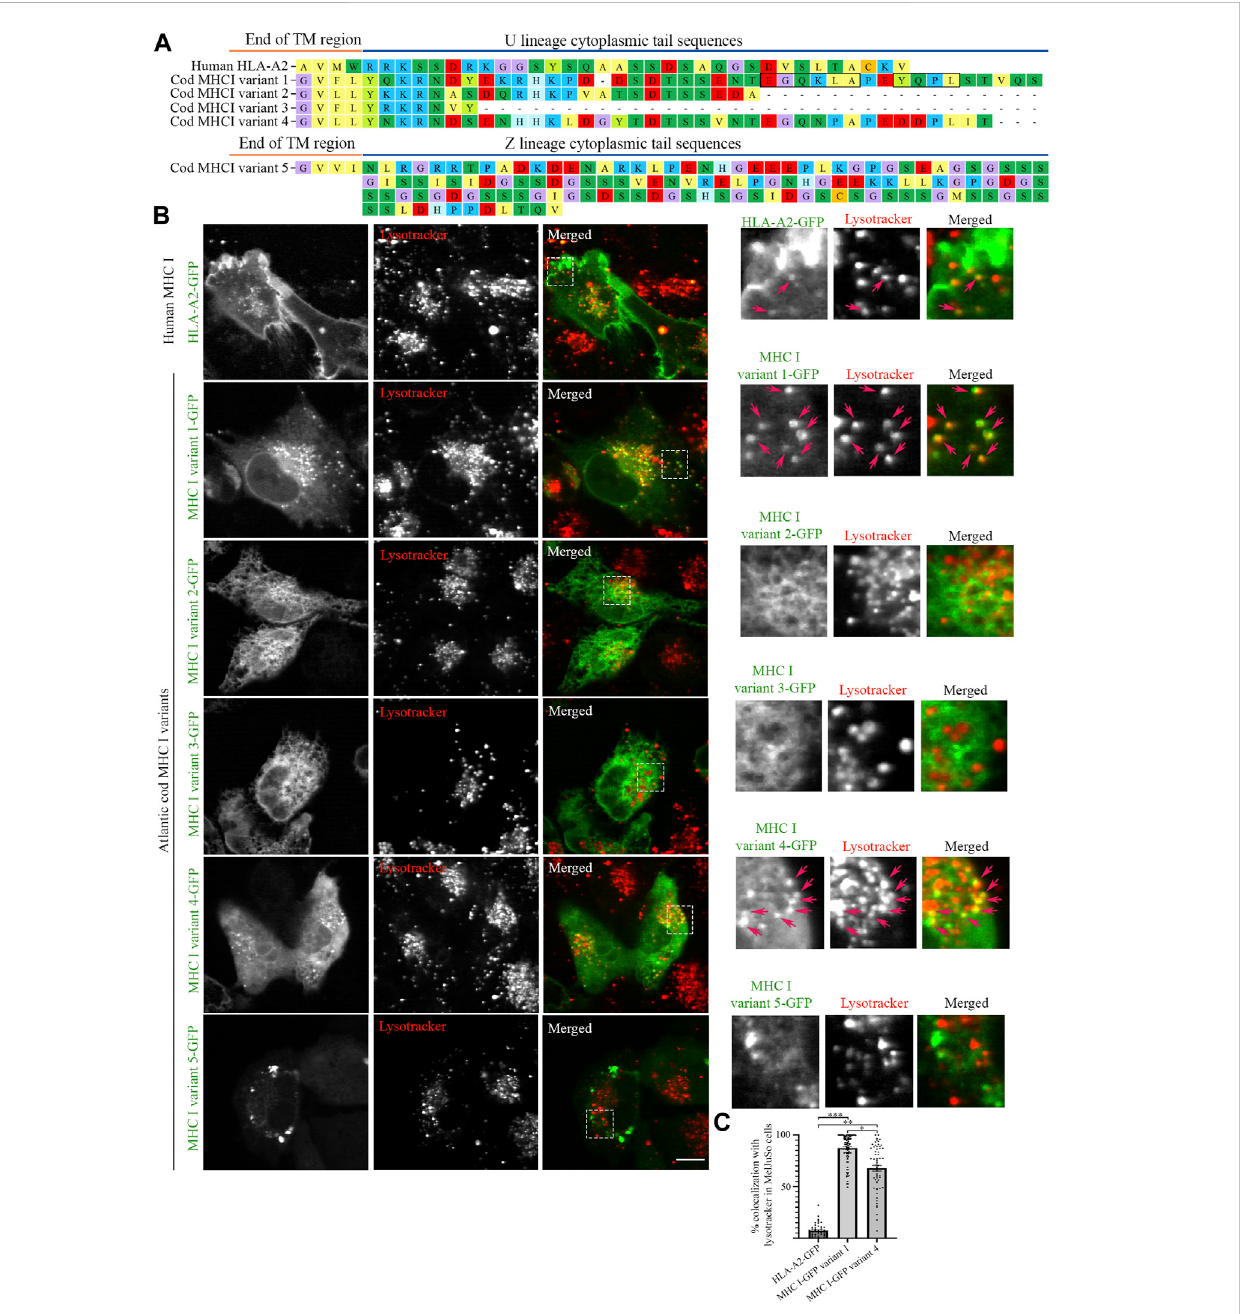
FIGURE 1 Intracellular localization of human MHC I and fi ve Atlantic cod MHC I variants in MelJuSo cells. (A) Amino acid sequences of the cytosolic tails of human HLA-A2 and fi ve selected Atlantic cod MHC I variants (four classical U-lineage MHC I variants and one non-classical Z-lineage MHC I variant). The sequences were manually curated and aligned with MEGA7. Hypothetical dileucine (EGQKLA) and tyrosine (YQPL) sorting signals in MHC I variant 1 are boxed. (B) Representative images of MelJuSo cells transiently transfected with human HLA-A2-GFP, or the fi ve selected Atlantic cod MHC I-GFP variants (green). Colocalization between green and red channels results in yellow signal in the merged panels. Cells were stained with lysotracker red and imaged using an Andor Revolution XD Spinning Disk microscope. Scale bar: 10 μ m. Magni fi cation of boxed areas are shown to the right of each image. Arrows indicate colocalization with lysotracker. (C) The graph represents the percentage of human HLA-A2-GFP, Atlantic cod MHC I-GFP variant 1 or variant 4 vesicles positive for lysotracker red. Colocalization was done by object-based analysis using ImageJ software. Values represent the mean ± s.e.m. from at least three independent experiments. n ≥ 52 cells. * p < 0.05, ** p < 0.01, *** p < 0.001 (Two-tailed paired Student t